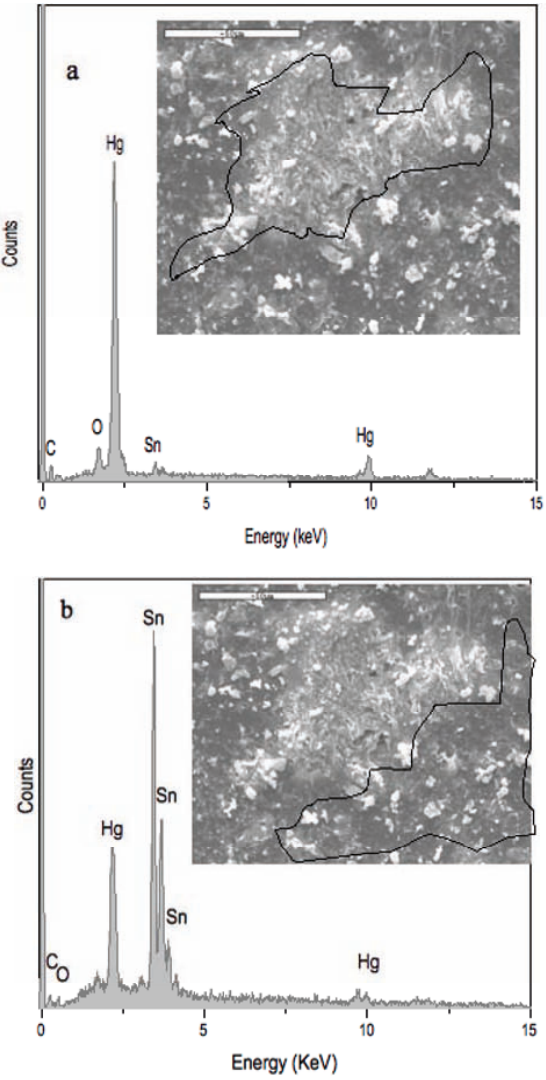
Figure 2. SEM/EDX analysis of the phases present in Sample 1: (a) mercury rich liquid phase; (b) tin-mercury solid